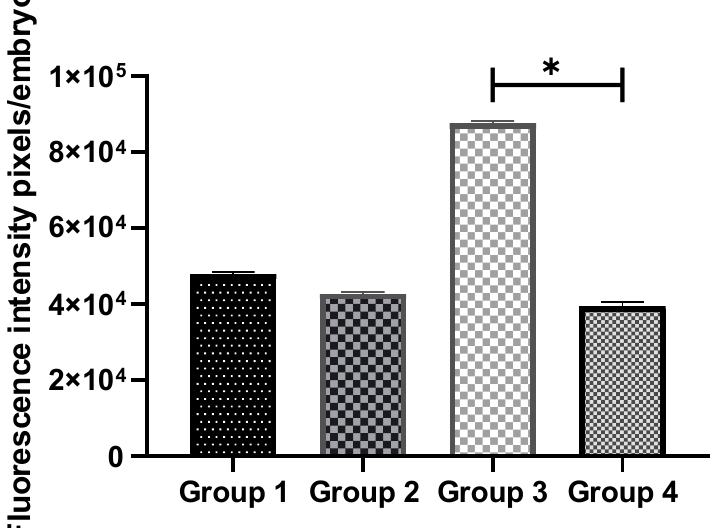
Figure 8. Comparison of cytochrome c expression between non-vitrified and vitrified embryos. Data are expressed as significant differences between the means ± SEM. * indicates p < 0.05. Group 1 (GSH-free medium); Group 2 (GSH-supplemented medium); Group 3 (GSH-free medium with vitrification); Group 4 (GSH-supplemented medium with vitrification).